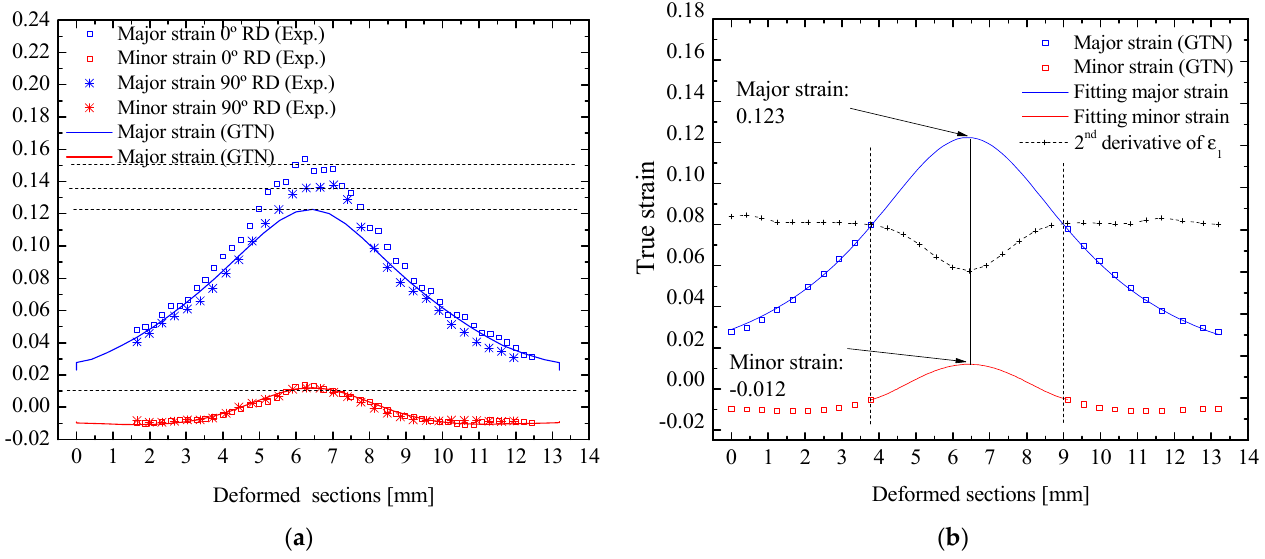
Figure 23. ( a ) Experimental and predicted major and minor strain in the centerline of the double- notched plane-strain sample and ( b ) limit strains from the plane-strain tension test simulations using the GTN model.